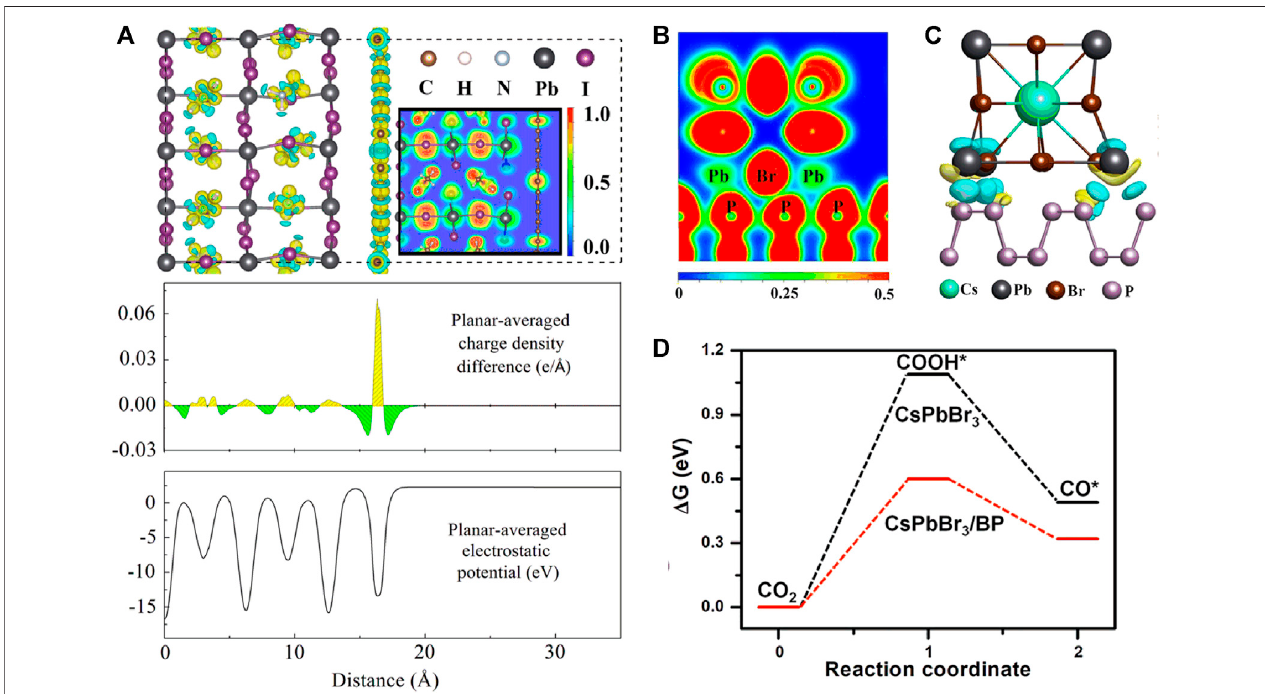
FIGURE 3 | (A) Calculated electrostatic potential, charge density difference, and electron localization function plots for graphdiyne/MAPbI 3 heterostructures with fi ve-layer interfaces (Glazer, 1972). Copyright (2019) John Wiley and Sons. (B) Electron localization function, and (C) charge density difference of the interface between the CsPbBr 3 and black phosphorus (Yu, 2019). (D) Gibbs free-energy diagram of CsPbBr 3 /black phosphorus and CsPbBr 3 heterostructures in the photocatalytic CO 2 reduction process (Yu, 2019). Copyright (2020) Elsevier.